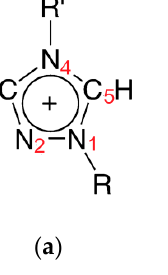
Figure 5. ( a ) Triazole ring of 1,2,4-triazolium ionic liquid cation with number of atoms in the ring; ( b ) resonance structures of 1,2,4-triazolium ionic liquid cation.